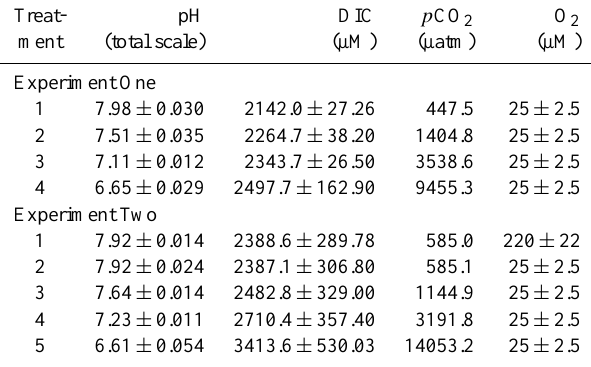
Table 1. Seawater chemistry for experiments one and two, as mea- sured by GCA logging and spot-sampling (pH, DIC, O 2 ) and cal- culated ( p CO 2 ) using CO2SYS (Robbins et al.,